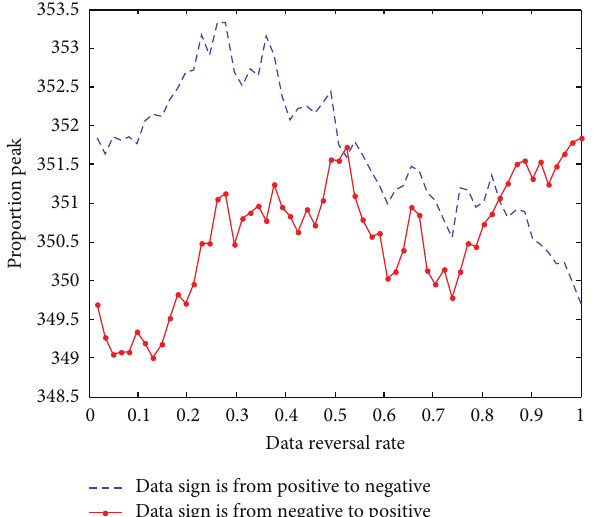
Figure 1: The proportion peak change with changing data reversal rate.